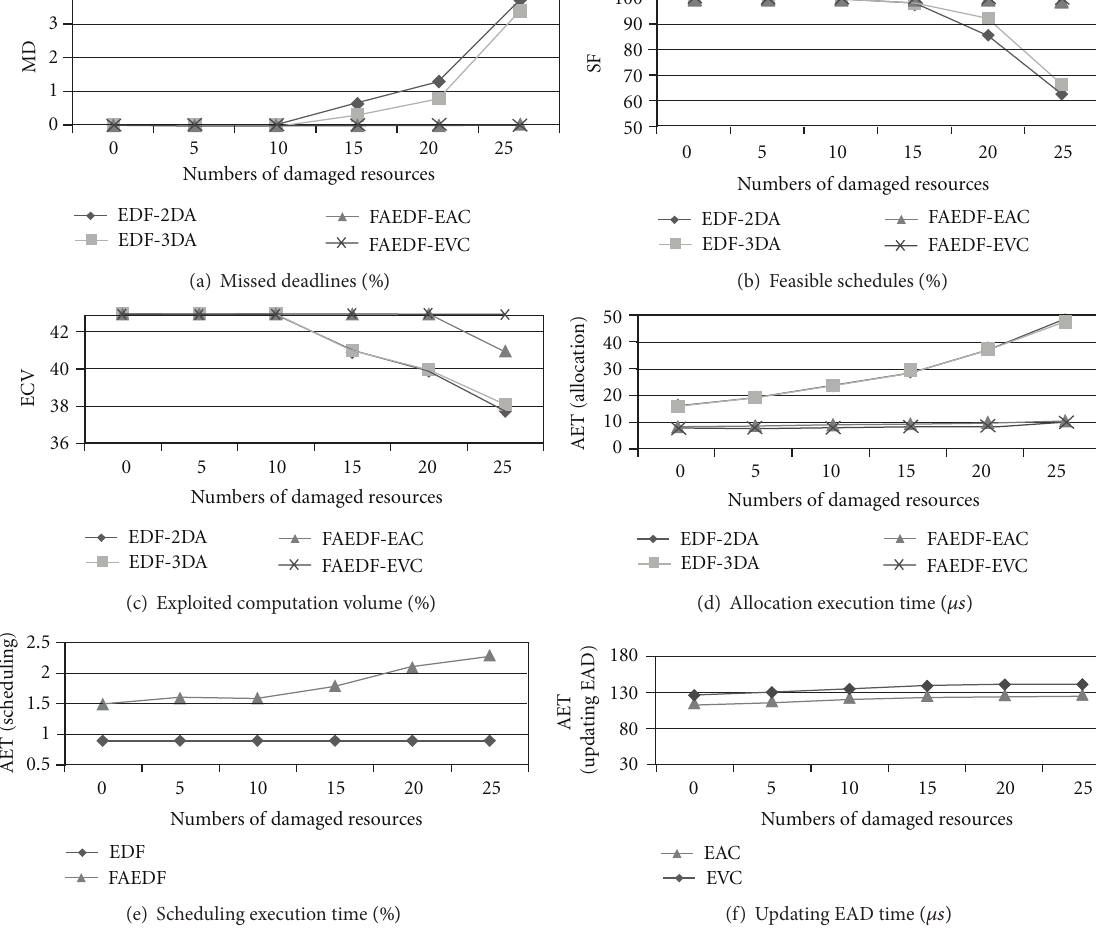
Figure 14: Low utilization of the FPGA and loose real-time constraints: 𝑈